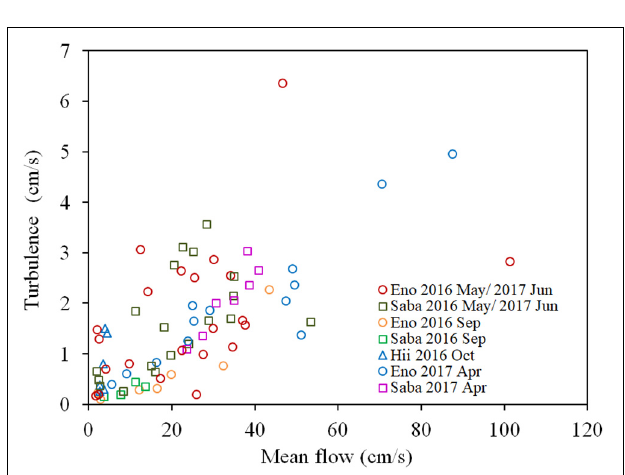
FIGURE 2 | The concentration of H 2 O 2 in E . densa tissue as a function of turbulence velocity at 80% depth in light-exposed (L) and dark-adapted (D) conditions. The “Labo Exp” represents data from the laboratory experiment (Ellawala et al., 2011). The dashed lines indicate the linear regressed lines with the gradient of 1.25 µ mol/[gFW (cm/s)] of the dark-adapted conditions of the same colored symbols of as those of the sampling rivers and seasons, respectively. H 2 O 2 is given in units of µ mol/gFW, and while the TVel (turbulence velocity) are in cm/s. The dates May, Sep (September), and Oct (October) represent data obtained in 2016 while Jun (June) and Apr (April) represent data of 2017. Eno, Saba, and Hii represent Eno, Saba, and Hii rivers including their tributaries, respectively.